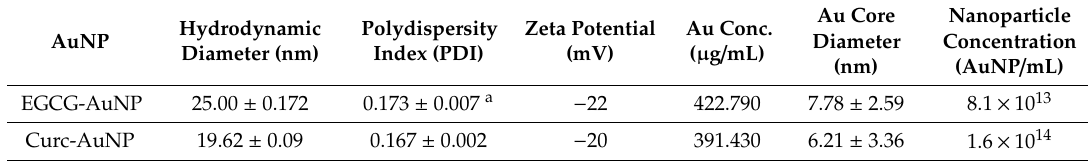
Table 3. Characterization data of EGCG-AuNPs and Curc-AuNPs.